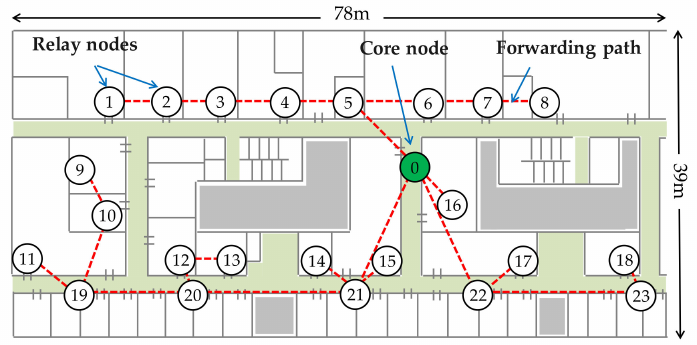
Figure 5. Node layout for